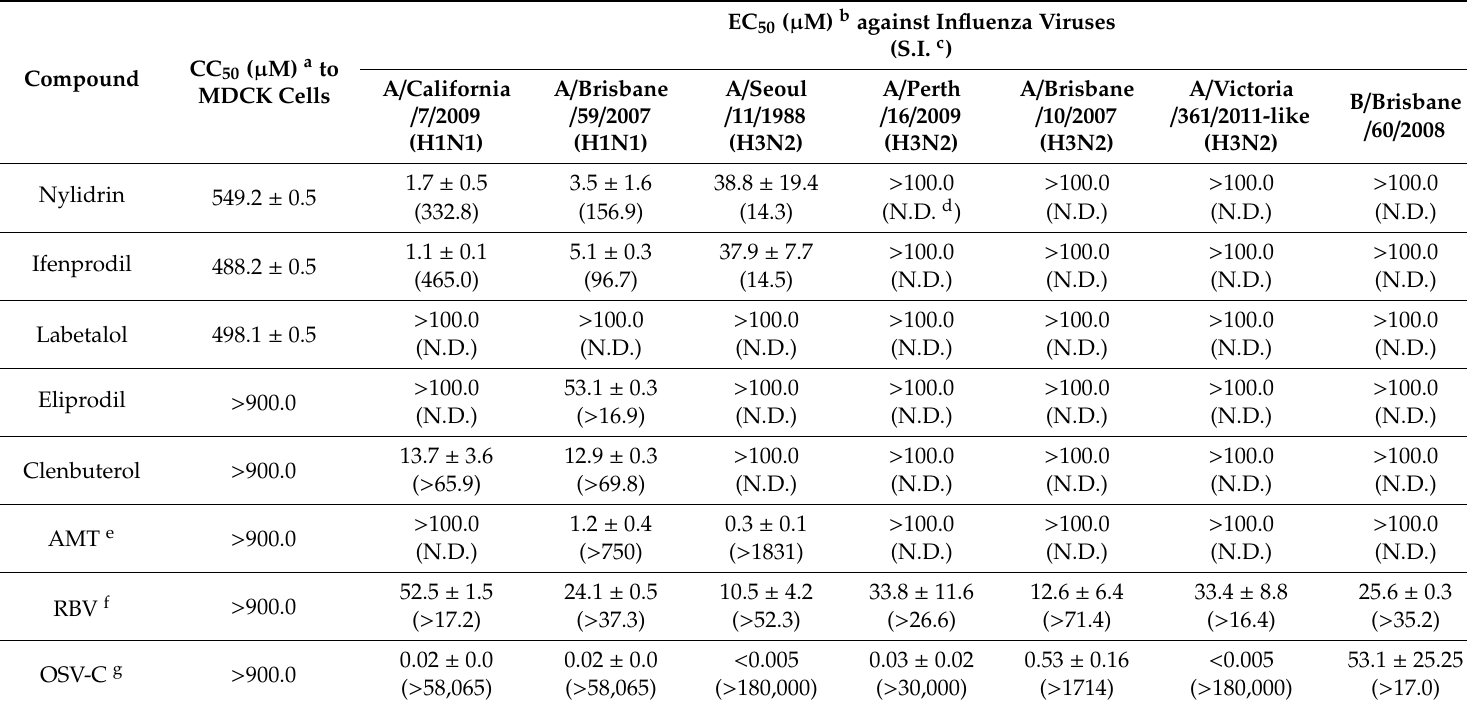
Table 2. Antiviral activity of nylidrin and its analogues against various influenza A and B viruses.